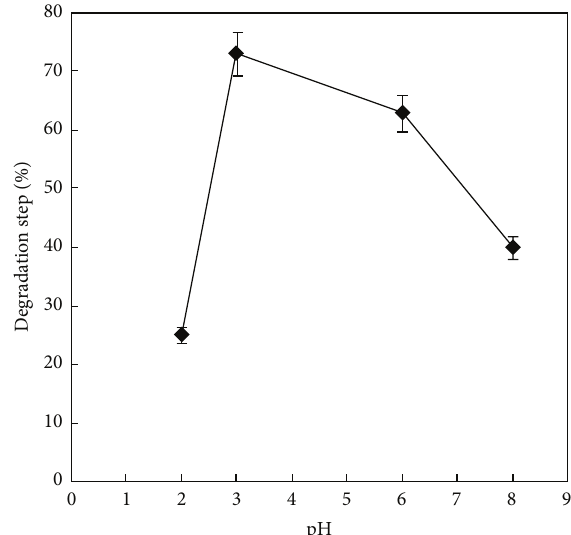
Figure 1: Effect of pH of reaction mixture on the degradation step of p -HBA.